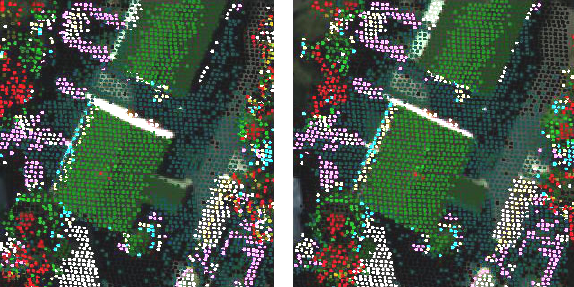
Figure 4. A cross-eye stereo image pair of relatively oriented ALS data and aerial images.